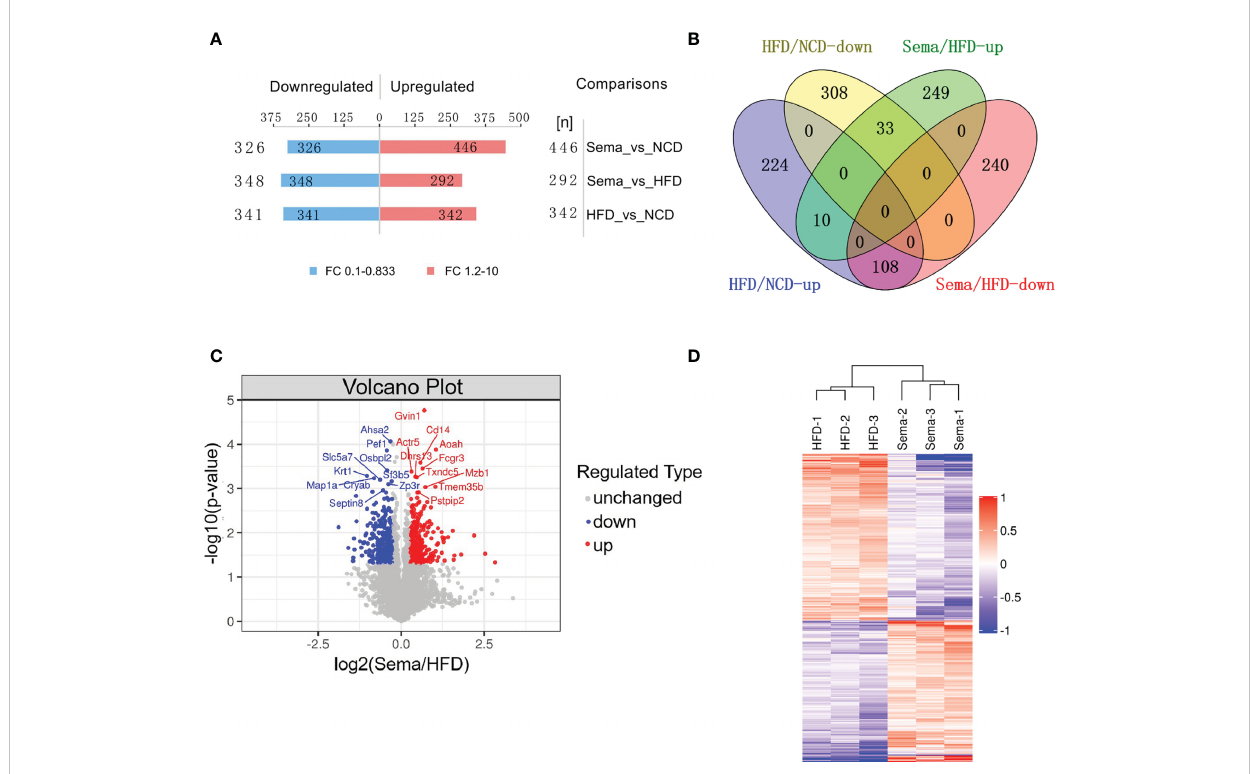
FIGURE 4 Identi fi cation and quantitative analysis of proteins. (A) The number of DEPs among each group. (B) The number of up-regulated and down-regulated proteins was compared between the two groups in Venn diagram. (C) Volcano plots show the distribution of signi fi cance and fold change of identi fi ed proteins between the Sema and HFD groups. The blue spots and red spots indicate signi fi cantly down-regulated and up-regulated proteins. Red indicates upregulation and blue represents downregulation. (D) Hierarchical clustering of DEPs from the Sema group compared with the HFD group. Red indicates upregulation, and blue represents